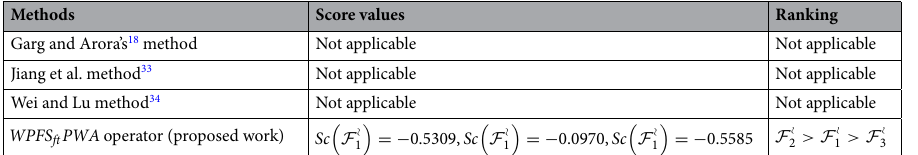
Table 7. Overall result of the comparative